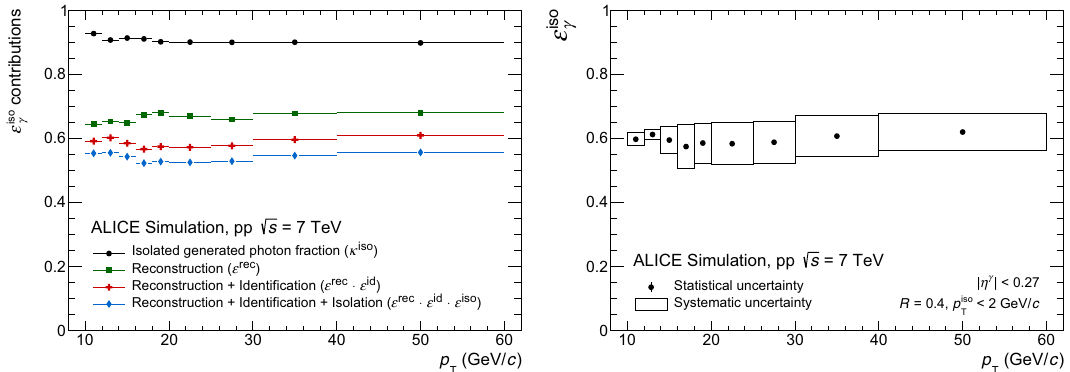
Fig. 6 Different contributions (reconstruction, identification, isolation) to the total efficiency (left) and total isolated photon efficiency (right) calculated using Eq. (13), all as a function of the reconstructed p